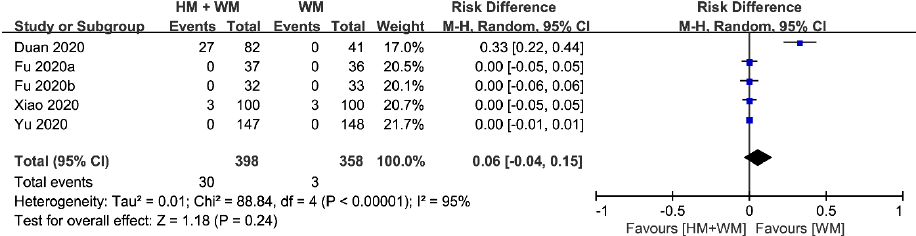
Figure 6. Comparison of herbal medicine and Western medicine (HM + WM) vs. Western medicine (WM) on occurrence of adverse